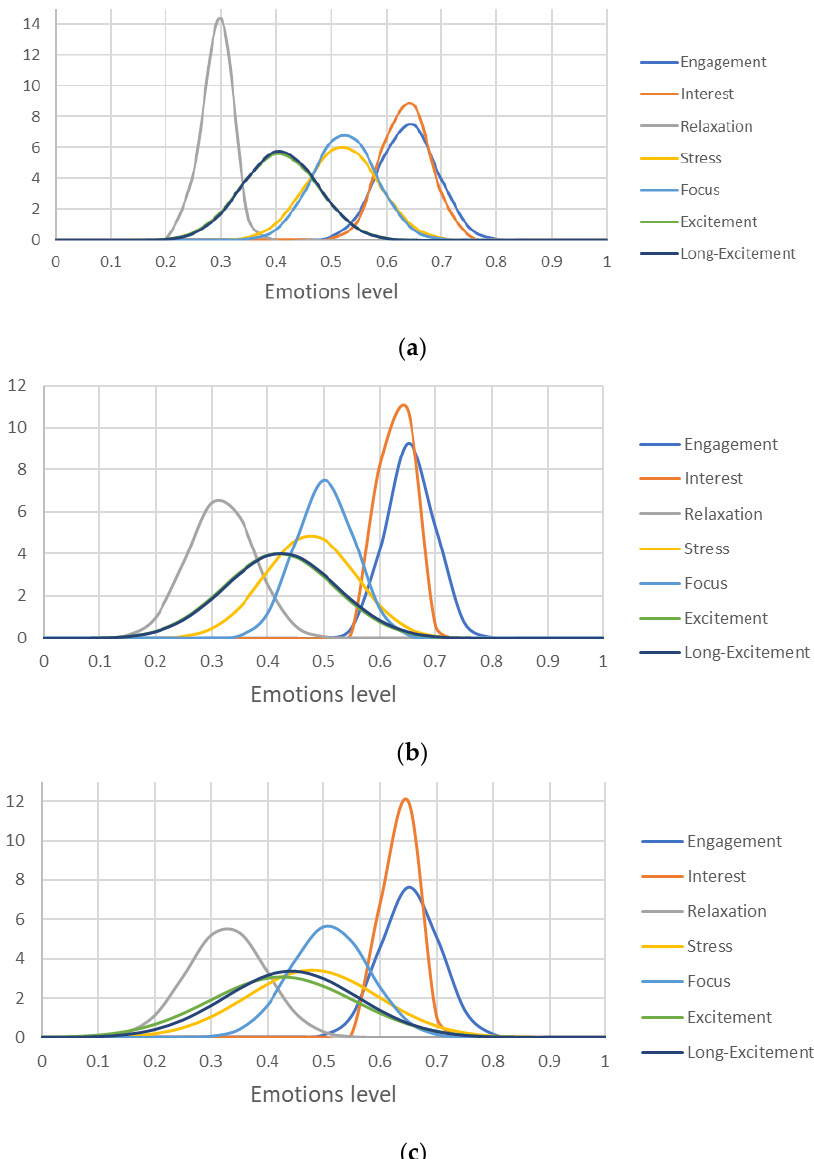
Figure 10. Normal distributions of the human profiling data: ( a ) box assembly alone, ( b ) box assembly with the cobot including the waiting time for the cobot, ( c ) box assembly with the cobot excluding the waiting time for the cobot. Table 2. Mean and std. deviation values for the human profiling data of the selected emotions (Stress, Engagement and Focus).